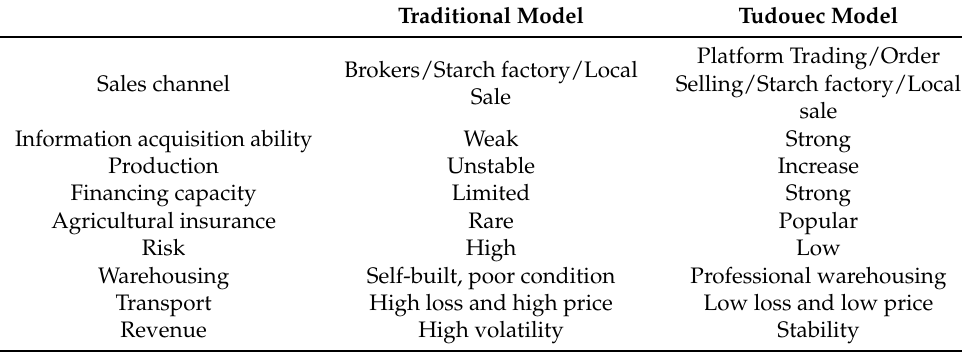
Table 4. Comparison of models based on the farmers’